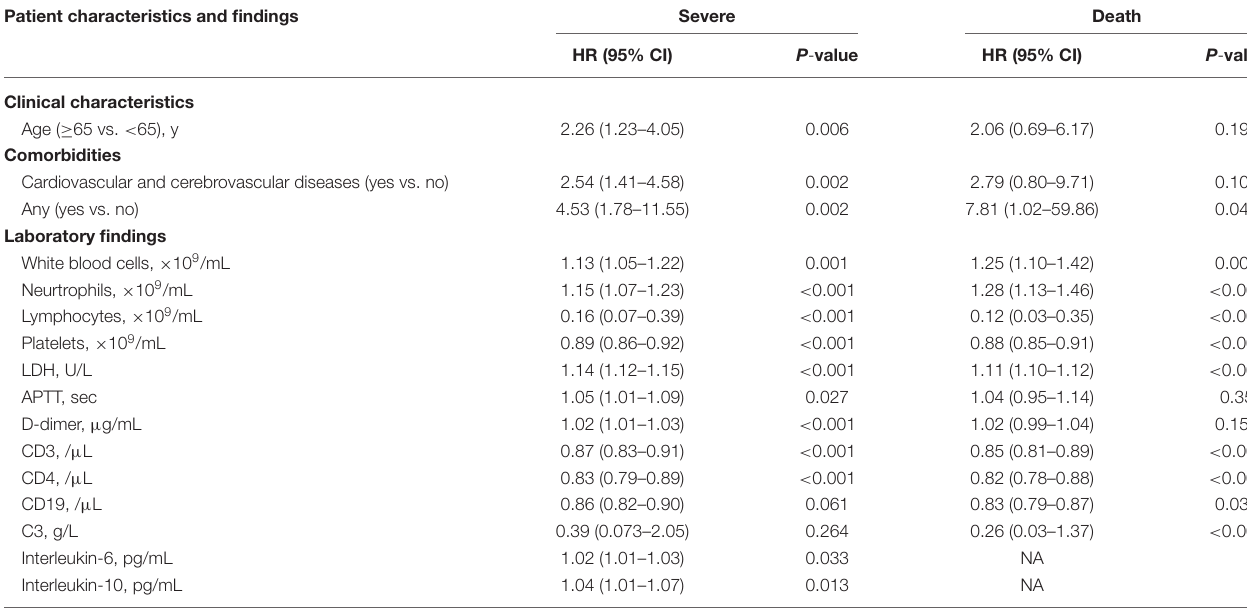
TABLE 4 | Bivariate Cox regression of factors associated with disease progression from onset to severe disease or to